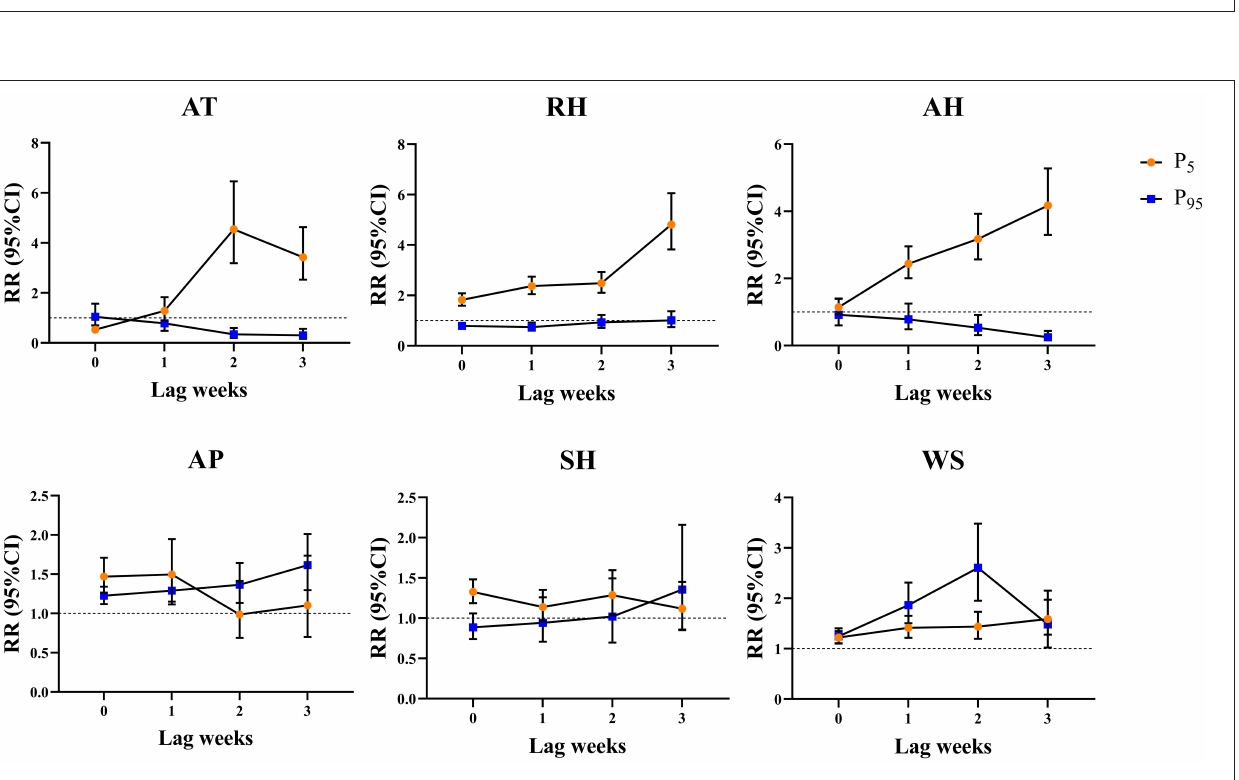
FIGURE 2 | Exposure-response relationship between the risk of influenza and AT (A) , AH (B) , RH (C) , AP (D) , SH (E) , and WS (F) at a three-week lag in Lanzhou, China during 2010–2019. The red line represents the cumulative relative risk (RR) of influenza, and the gray shaded region represents the 95% confidence interval (CI).